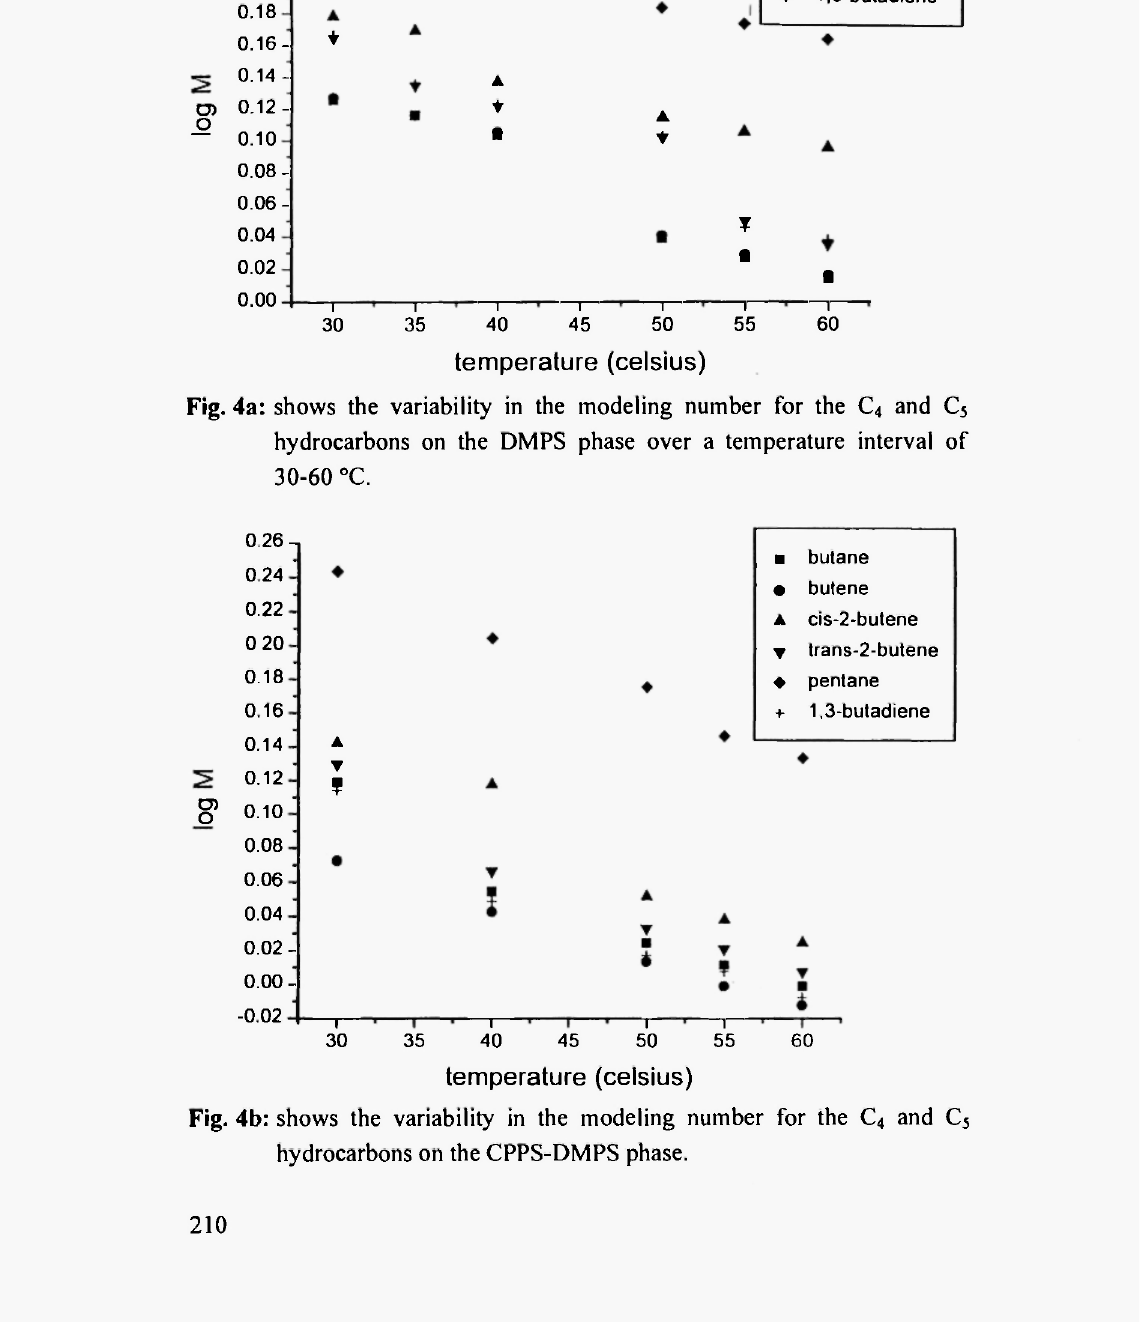
Fig. 4a: shows the variability in the modeling number for the C 4 and C 5 hydrocarbons on the DMPS phase over a temperature interval of 30-60 °C.